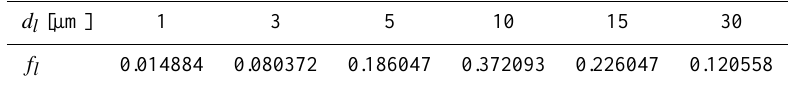
Table 3. Size factors for the representation of volcanic ash emissions within a sectional approach. The diameters of the size bin centers are denoted by d l . The distribution factors f l are taken from Schumann et al. (2011). d l [µm] 1 3